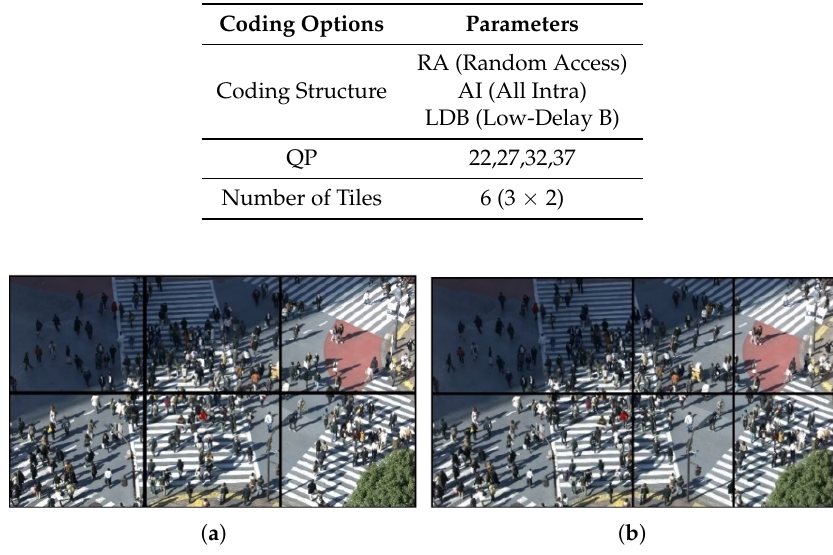
Table 8. General coding options.